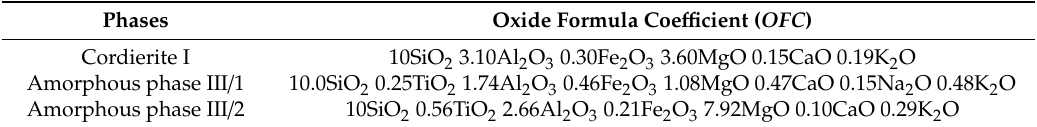
Table 3. Compiled oxide formula coe ffi cients ( OFC ) for calculated